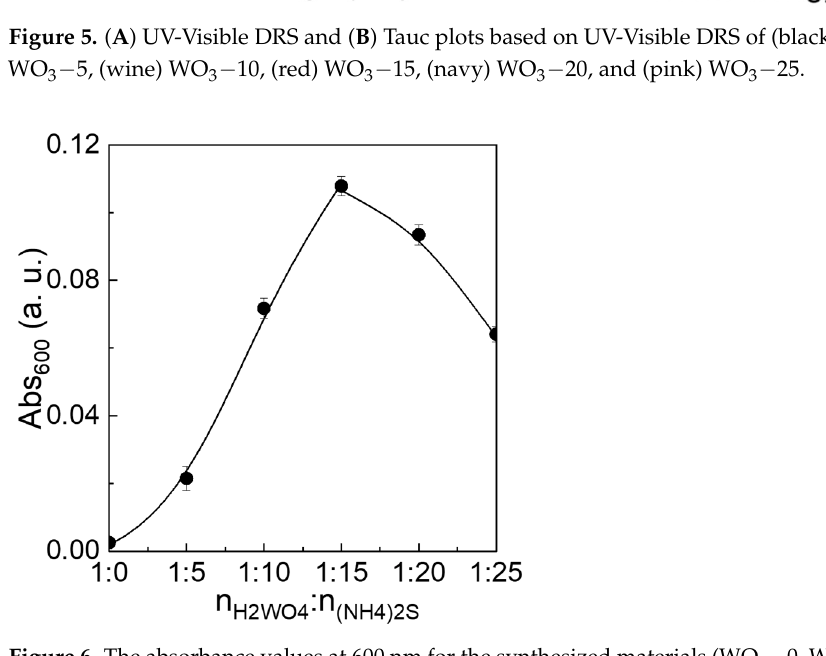
Figure 5. ( A ) UV-Visible DRS and ( B ) Tauc plots based on UV-Visible DRS of (black) WO 3 − 0, (blue) WO 3 − 5, (wine) WO 3 − 10, (red) WO 3 − 15, (navy) WO 3 − 20, and (pink) WO 3 − 25.